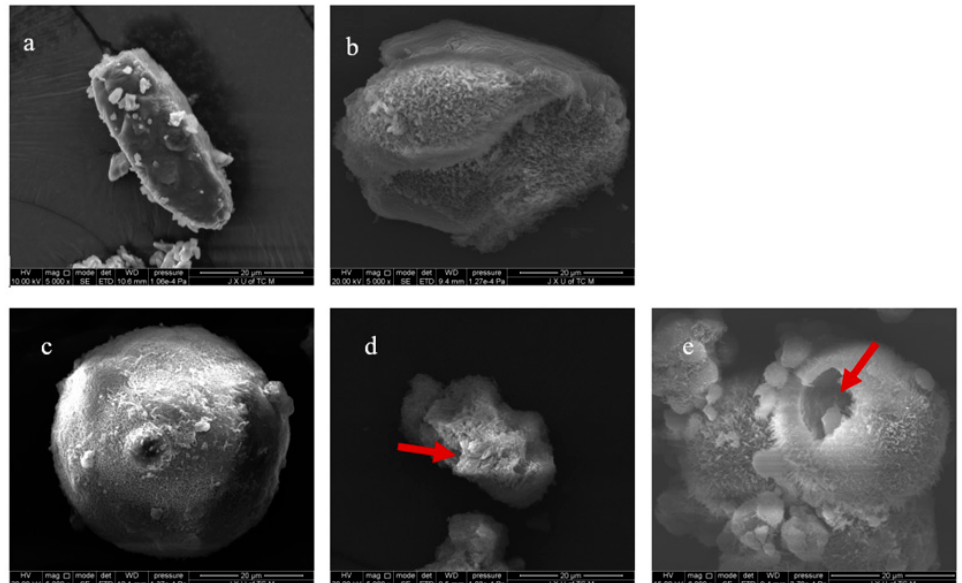
Figure 1. The scanning electron photomicrographs of materials. ( a ), Lactose (the raw material) (5000 X); ( b ), Lactose-0 (processed without PVP K30) (5000 X); ( c ), Lactose-P1 (processed with 1% PVP K30) (5000 X); ( d ), Lactose-P2 (processed with 2% PVP K30) (5000 X); ( e ), Lactose-P3 (processed with 3% PVP K30) (6000 X).